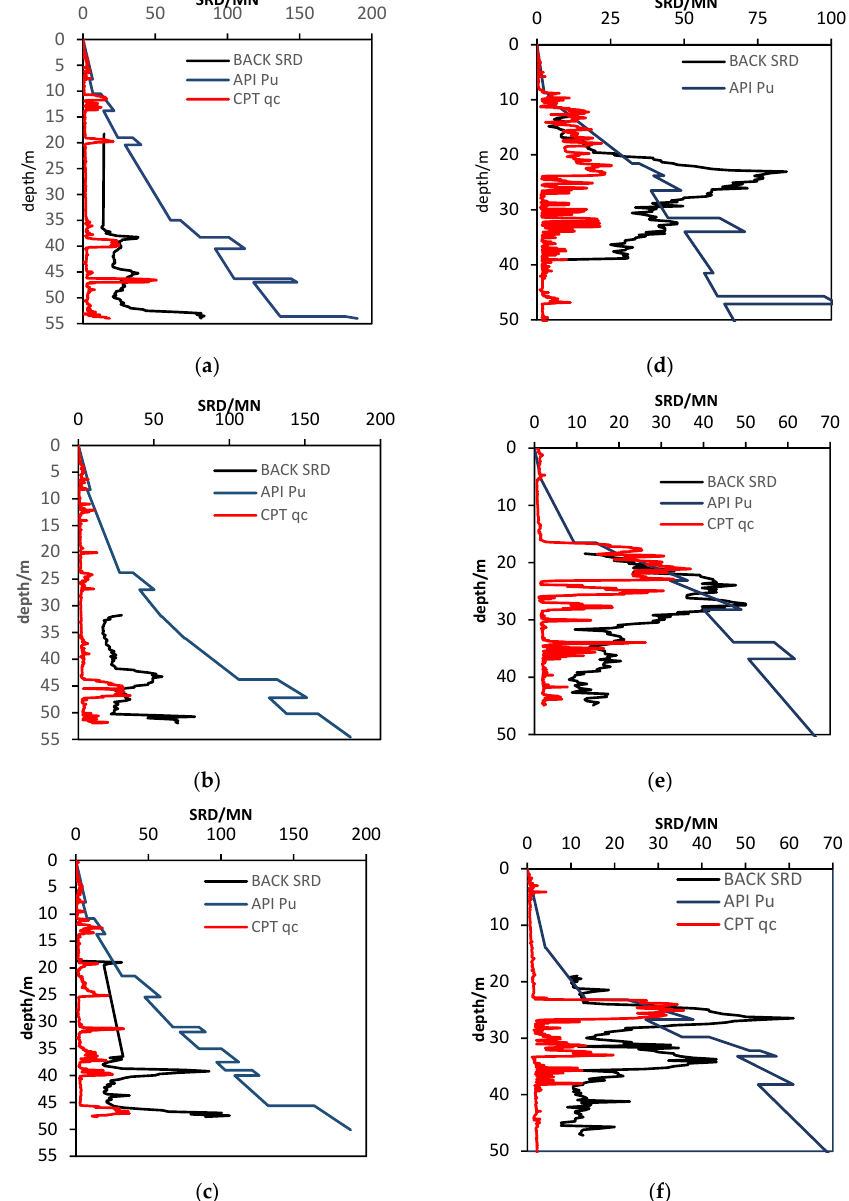
Figure 4. Comparison of SRD obtained by back analysis, Pu from API, and qc of CPT. ( a ) Case 1 (a); ( b ) Case 1 (b); ( c ) Case 1 (c); ( d ) Case 2 (a); ( e ) Case 2 (b); ( f ) Case 2 (c).